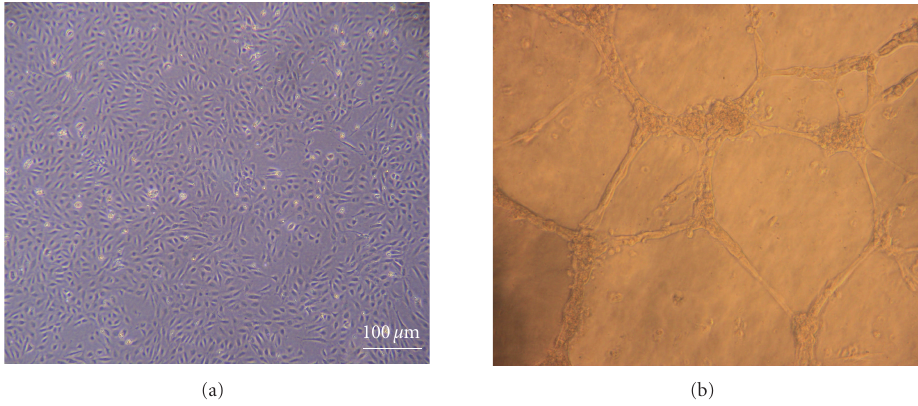
Figure 4: Endothelial progenitor cells derived from human umbilical cord blood (a) exhibit classic cobble-stone morphology (light microscopy × 40) and (b) form tube-like structures when seeded on Matrigel basement membrane matrix (light microscopy ×